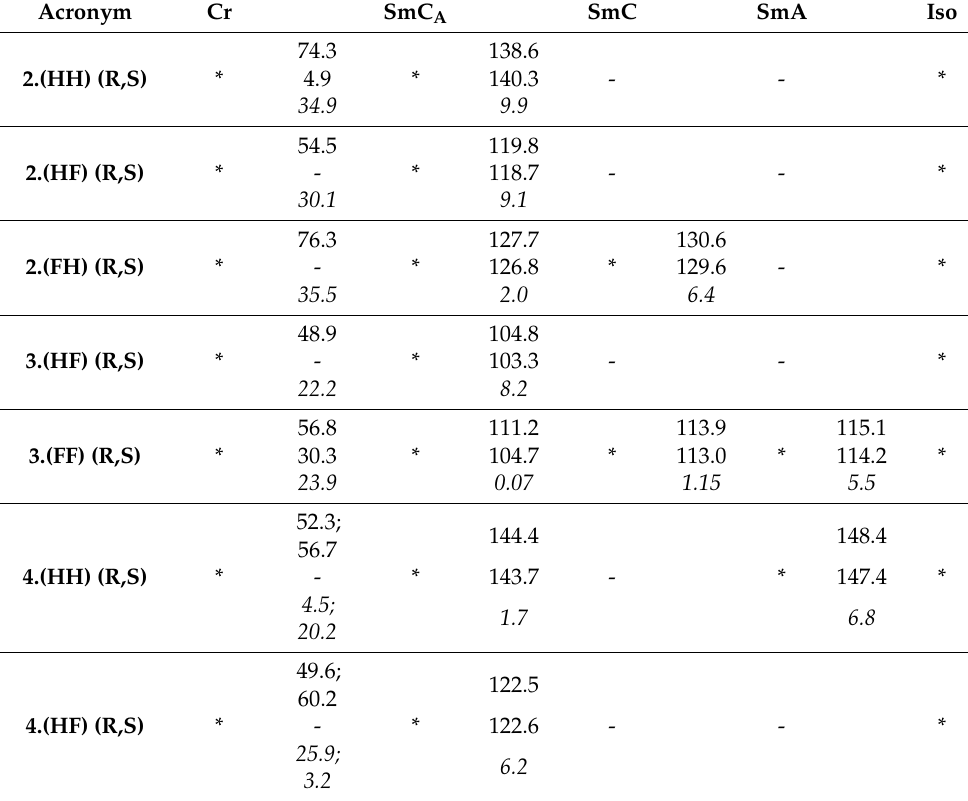
Table 2. The phase transition temperatures [ ◦ C] and enthalpies [J · g − 1 ] of the synthesized racemic mixtures. (“*” means that the phase is observed and “-” means that it is not observed; The enthalpy is indicated by the